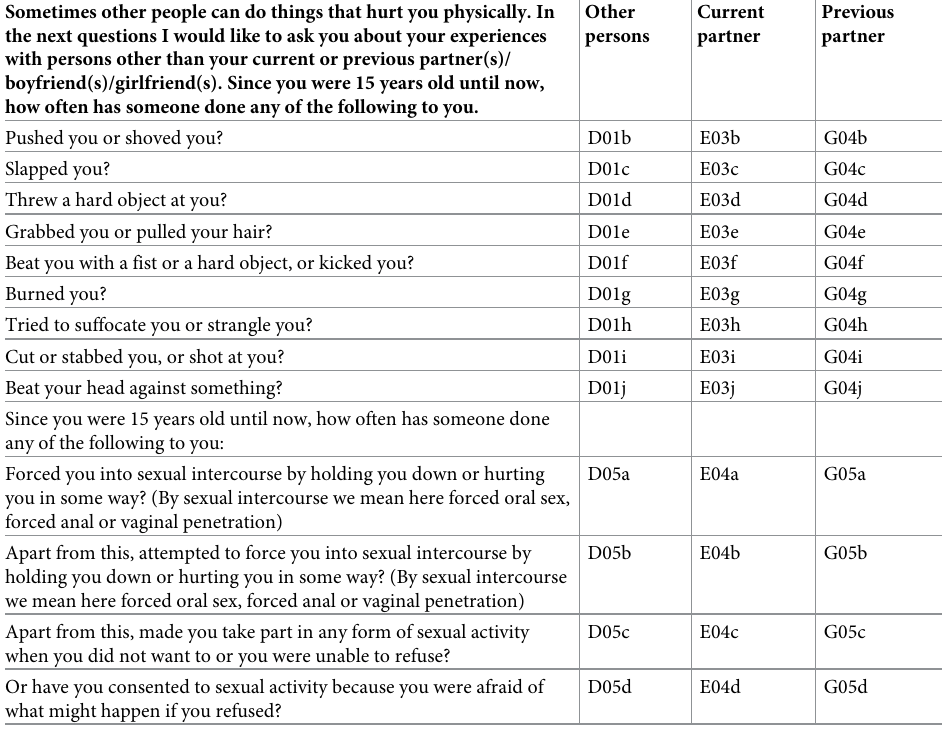
Other Current persons